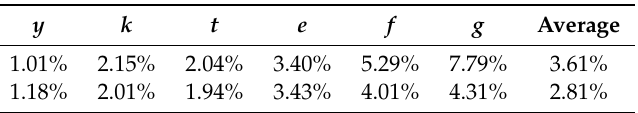
Table 12. Percentage difference from original equilibrium.